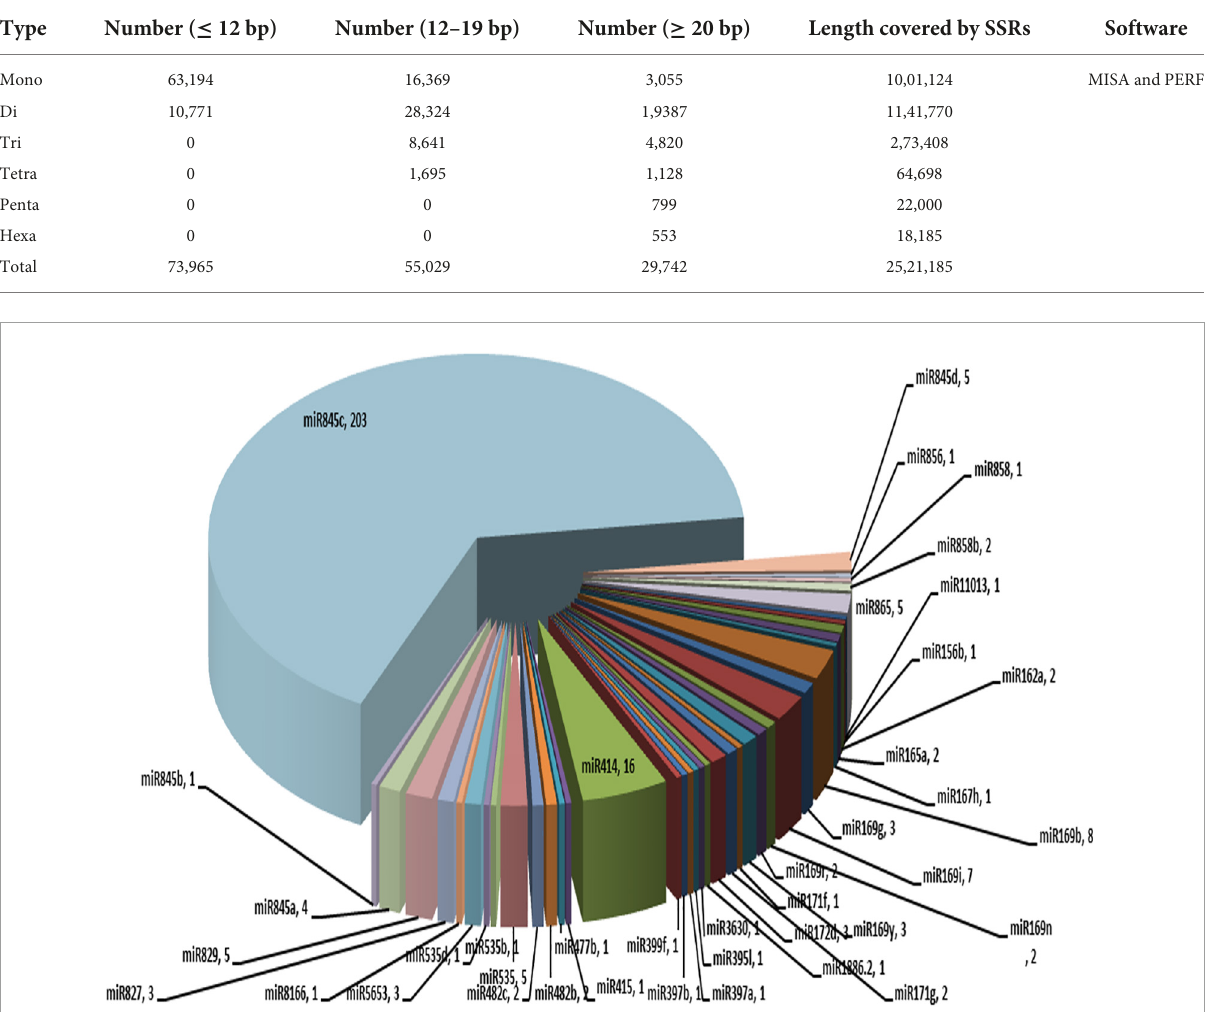
TABLE 7 Identified simple sequent repeats in pomegranate genome.